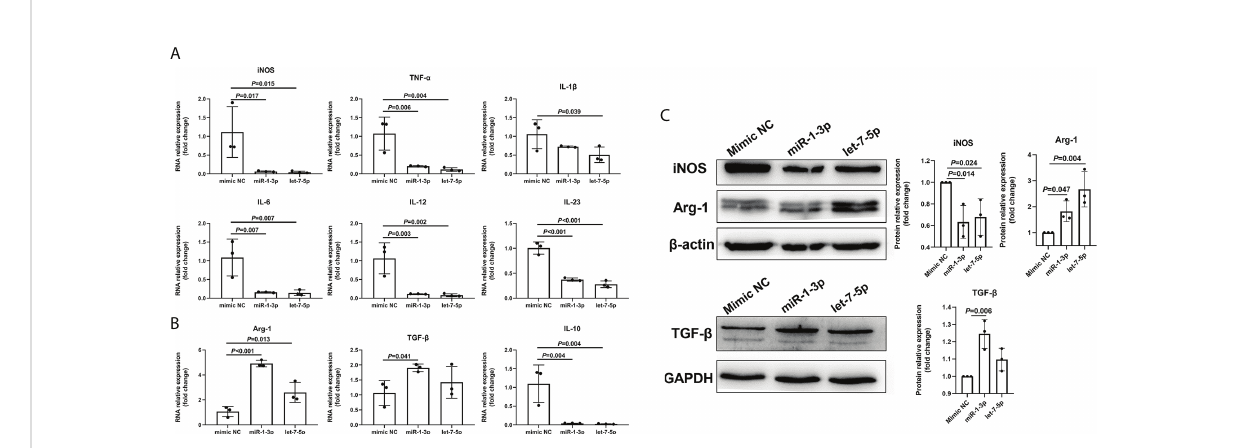
FIGURE 5 miR-1-3p mimic (50 nM) and let-7-5p mimic (50 nM) were used to stimulate mouse BMDMs, and qRT-PCR and western blotting were used to detect the levels of related in fl ammatory cytokines. (A) The M1-type macrophage marker factors were analyzed using qRT-PCR. (B) The M2-